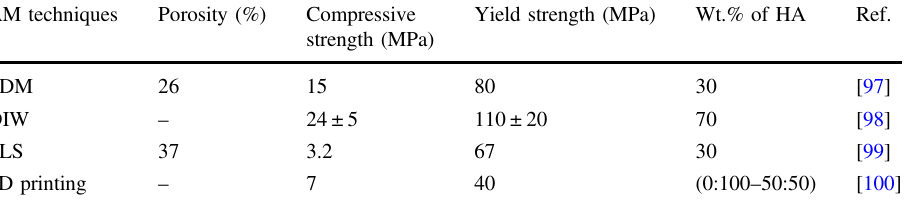
Table 3 HA constructs processed by additive manufacturing